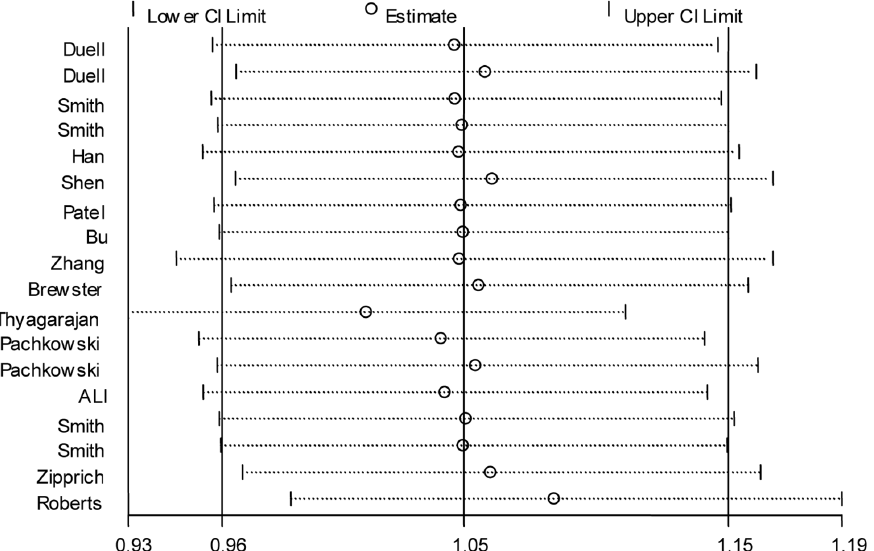
Figure 5. Sensitivity analysis of the association between the XRCC1 Arg399Gln and breast cancer risk for the additive model.